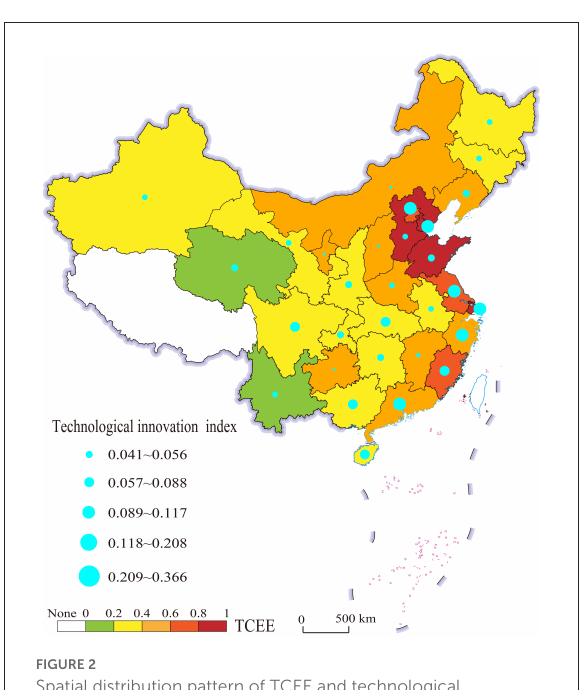
FIGURE2 Spatial distribution pattern of TCEE and technological innovation index in